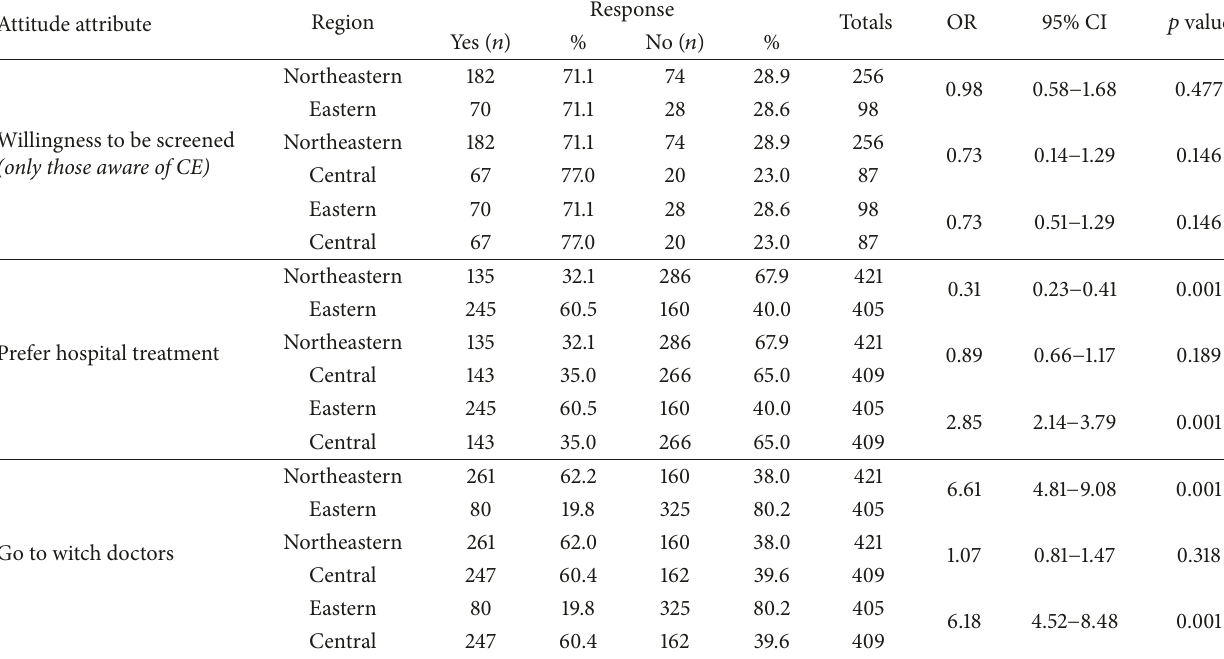
Table 5: Attitudes of the communities towards screening and treatment for CE infection. Attitude